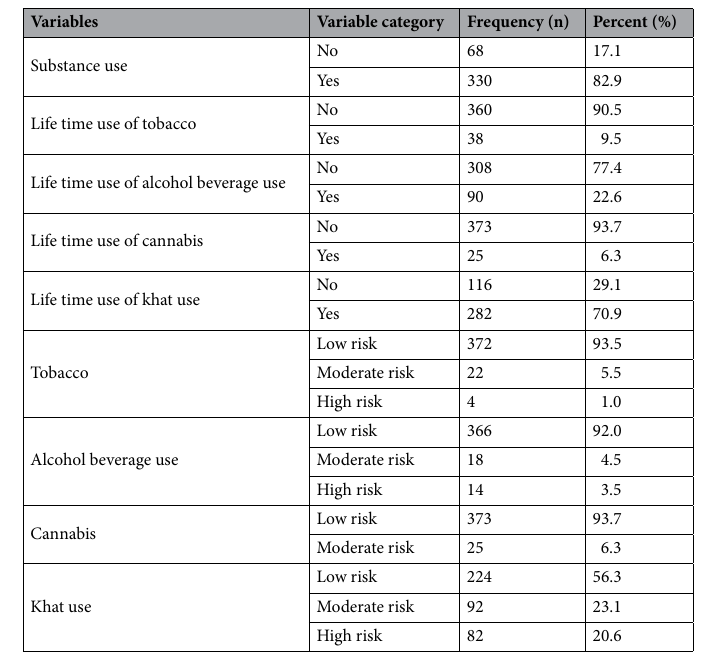
Table 2. Substance related characteristics of family caregivers of patients with mental illness (n = 398) at DRH, 2020 (n = 398).